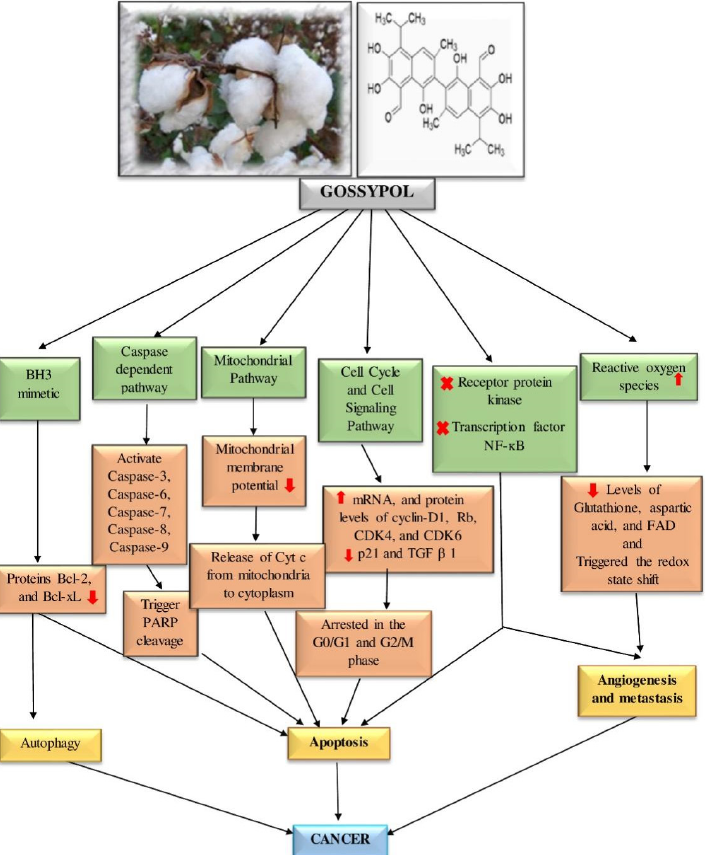
Figure 7. Gossypol’s activity against cancerous cells by affecting different cellular pathways and enzymes. ↑ , increase or upregulation; ↓ decrease or downregulation; x, inhibition.